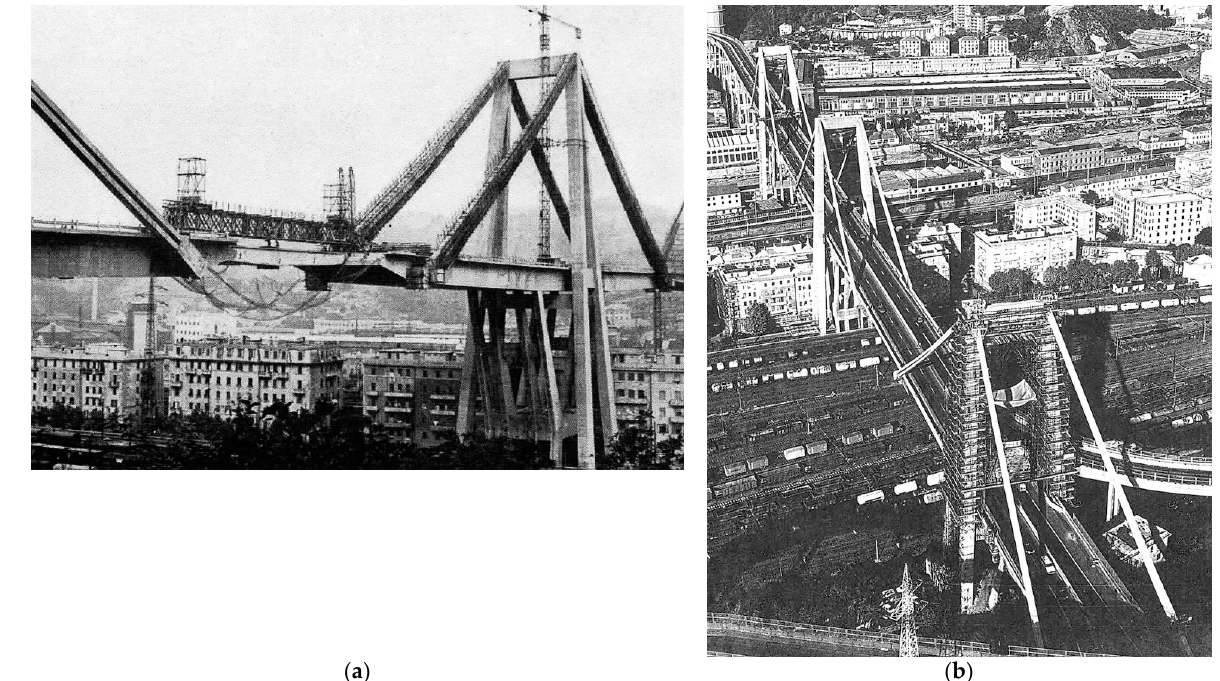
Figure 6. ( a ) Support No. 11 with scaffolding in the lower part. ( b ) Support No. 11 with scaffolding at full height (Italstrade, 1988).